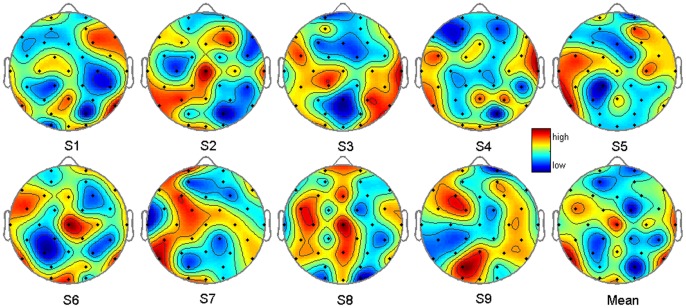
Channel weights of PLCV-RFE.Channel weights acquired by PLCV-RFE are displayed by the topography with all subjects and the averaged one.